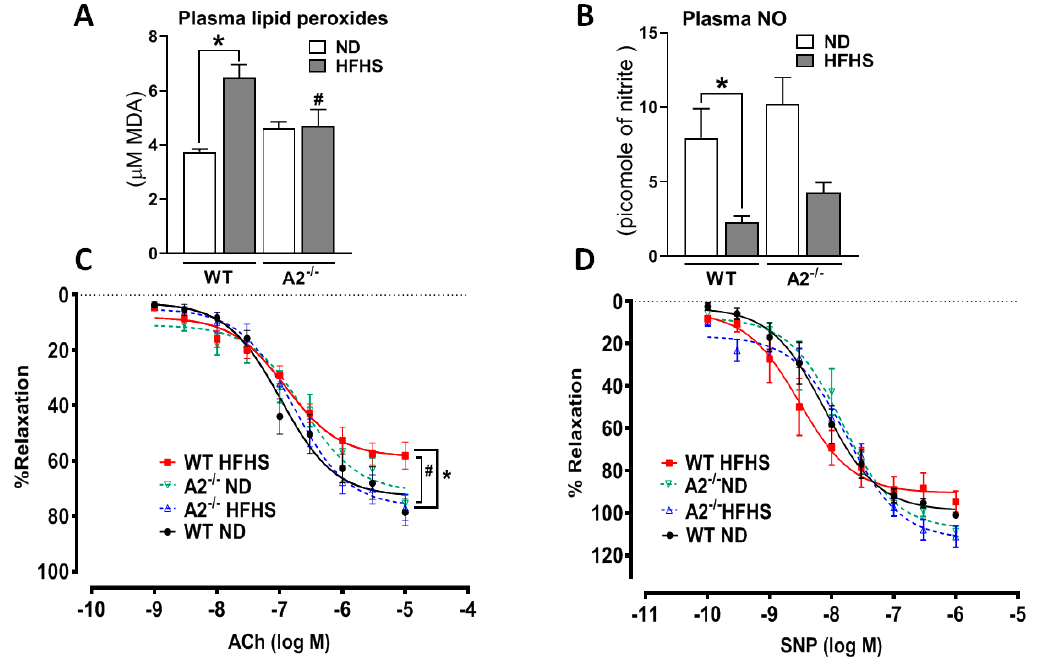
Figure 7. A2 deletion limited HFHS-induced oxidative stress, preserved NO levels and endothelium-dependent vasorelaxation to acetylcholine (ACh). Lipid peroxides are expressed as micromolar of malondialdehyde (MDA) ( A ), n = 5–9 mice/group, and plasma NO is expressed as picomoles of nitrite ( B ), n = 5–9 mice/group. Effects of A2 deletion on endothelium-dependent vasorelaxation to acetylcholine (ACh) ( C ), n = 7–10 mice per group, and sodium nitroprusside (SNP) ( D ), n = 4–5 mice per group. Values are mean ± SEM. * P < 0.05 when compared to ND-fed mice within the same genotype, # P < 0.05 when compared to WT on the same diet.